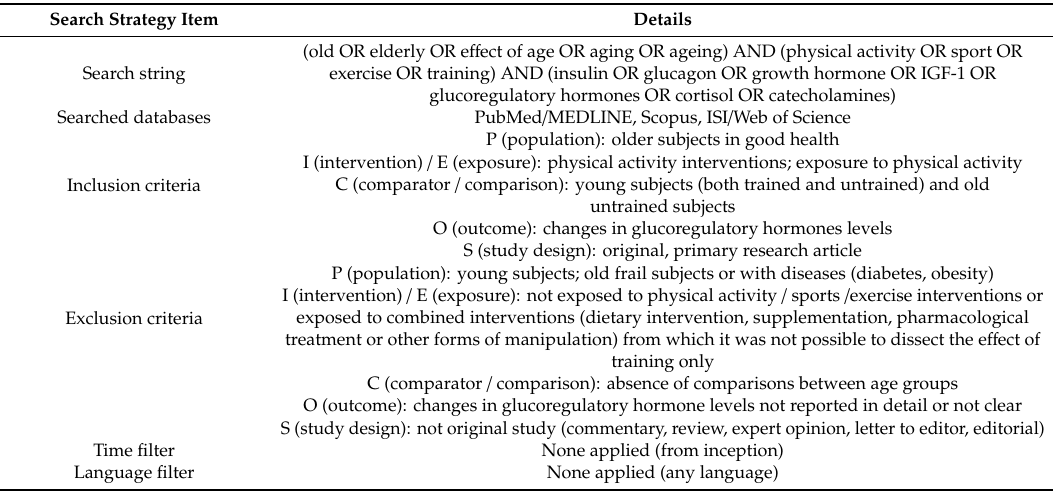
Table 1. Search strategy adopted in the present comprehensive review of the literature for retrieving studies investigating the e ff ects of physical activity and exercise on glucoregulatory hormones in elderly